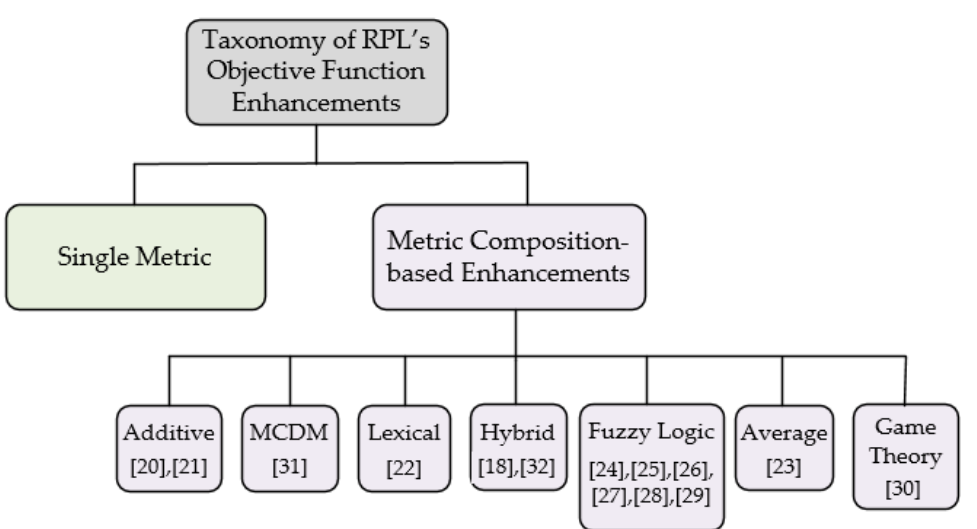
Figure 1. Taxonomy of Routing Protocol for Low Power and Lossy Networks (RPL) objective function enhancement mechanisms.